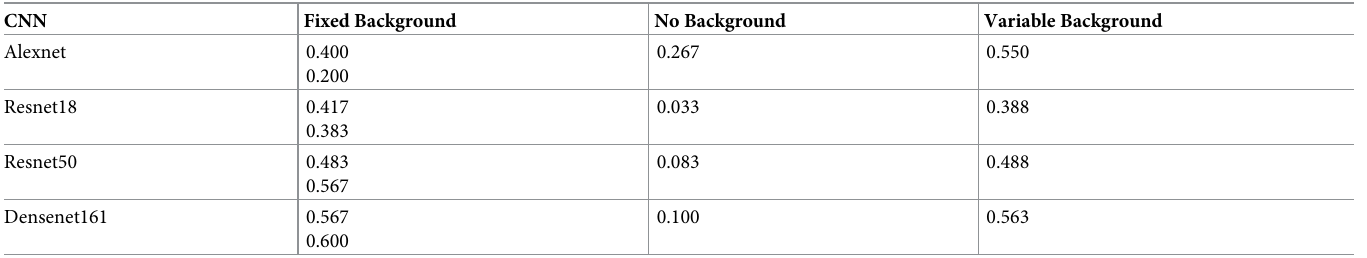
Table 2. Top 5 accuracy of each